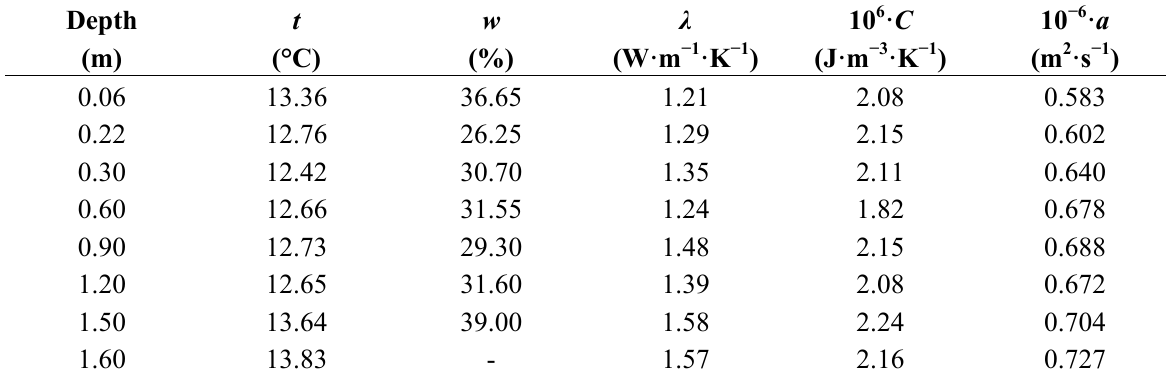
Table 1. Thermal characteristics of the